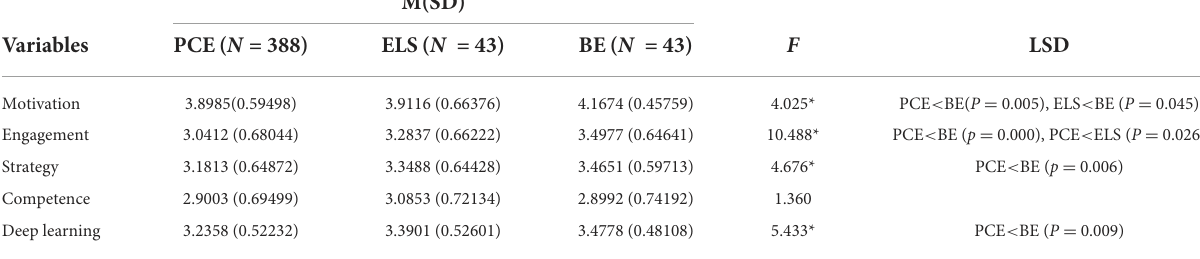
TABLE 9 ANOVA for comparison of students’ deep learning across English as a foreign language (EFL) course